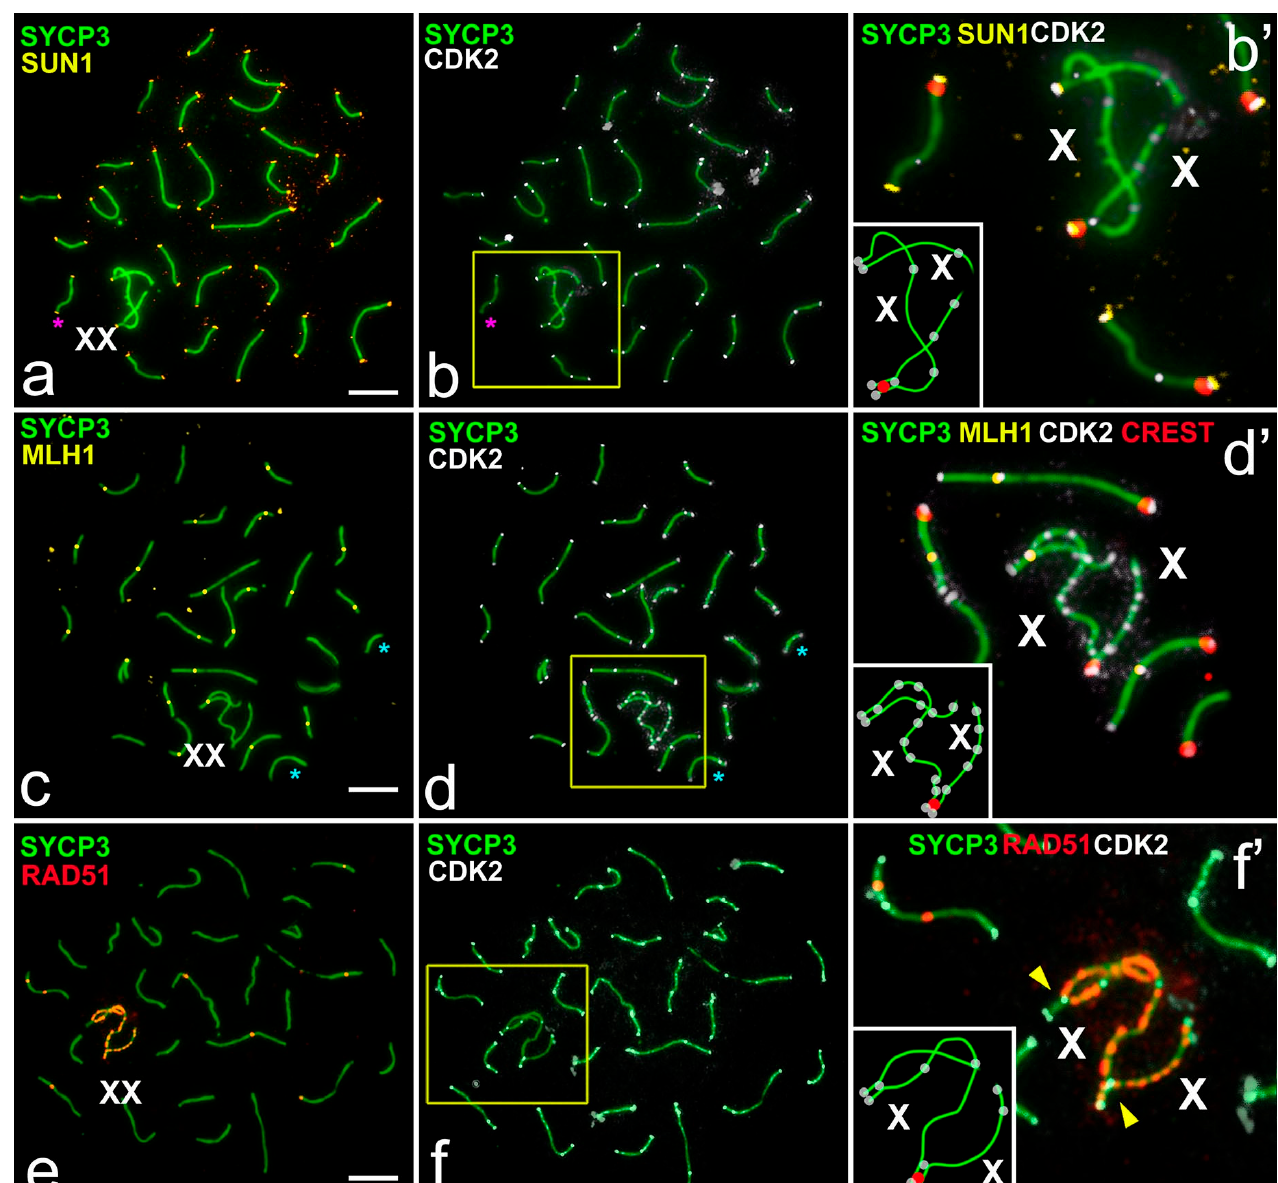
Figure 4. CDK2, SUN1, MLH1, and RAD51 distribution in meiotic chromosomes of spermatocytes of the mole vole E. talpinus . SCs were immunostained using antibodies to SYCP3 protein (green), centromeres–antibodies to proteins of kinetochores (CREST, red), and kinase CDK2 using antibodies to CDK2 (white). Schemes of sex chromosome synapsis, centromeric regions (red), and CDK2 (white) foci are shown in the insets ( b’ , d’ , f’ ). Pink stars point to non-colocalization of the SUN1 and CDK2 foci in autosomal bivalent. Blue stars point to non-colocalization of the MLH1 and CDK2 foci in some autosomal bivalents. ( a , b ) CDK2 (white) and SUN1 (yellow) colocalized in the telomeric sites of chromosomes. CDK2 signal was detected in asynaptic parts of the X chromosomes ( b’ ); ( c , d ) Colocalization of CDK2 (white) and MLH1 (yellow) in the interstitial sites of autosomal SCs. Asynaptic parts of the sex (XX) bivalent demonstrated numerous CDK2 foci, clear CDK2 signals in the telomeric sites, and one CDK2 focus in one of the synaptic segments ( d , d’ ); ( e , f ) CDK2 (white) and RAD51 (red) signals did not colocalize and had different positions in the chromosomes. Asynaptic parts and one of the synapsed segments showed numerous RAD51 foci. CDK2 signals localized in the telomeric sites, at the MLH1-positive positions (yellow arrowheads, see ( c ) [25]), and in the asynaptic parts of the XX bivalent ( f’ ). Scale bar ( a – f ) = 5 µ